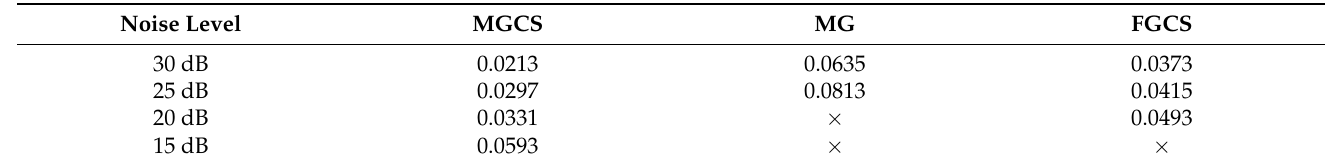
Table 2. The relative errors of inversion results from three different